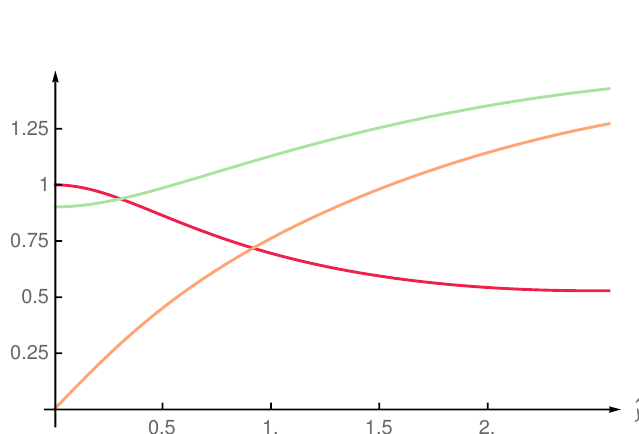
(b) Different contributions to the on-shell Schrödinger potential (5.38) in units of (cid:96) curvature + flux(red), Casimir (blue), and their sum (purple). Notice that when the flux is on-shell the equation satisfied by u becomes non-linear, but the non-linearity is mild enough that the intuition from the Schrödinger problem still applies.